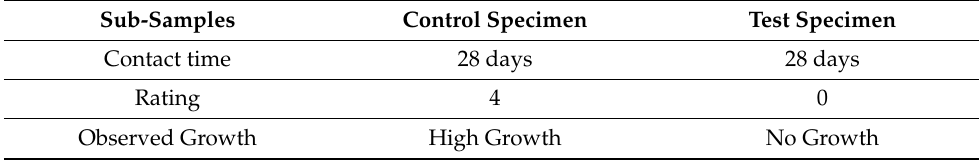
Table 7. Antifungal activity of PLA NF filter media containing manuka triketone (5 wt.%) against Aspergillus niger tested according to ASTM G21 [45]. Note on antifungal rating: 0 no growth,